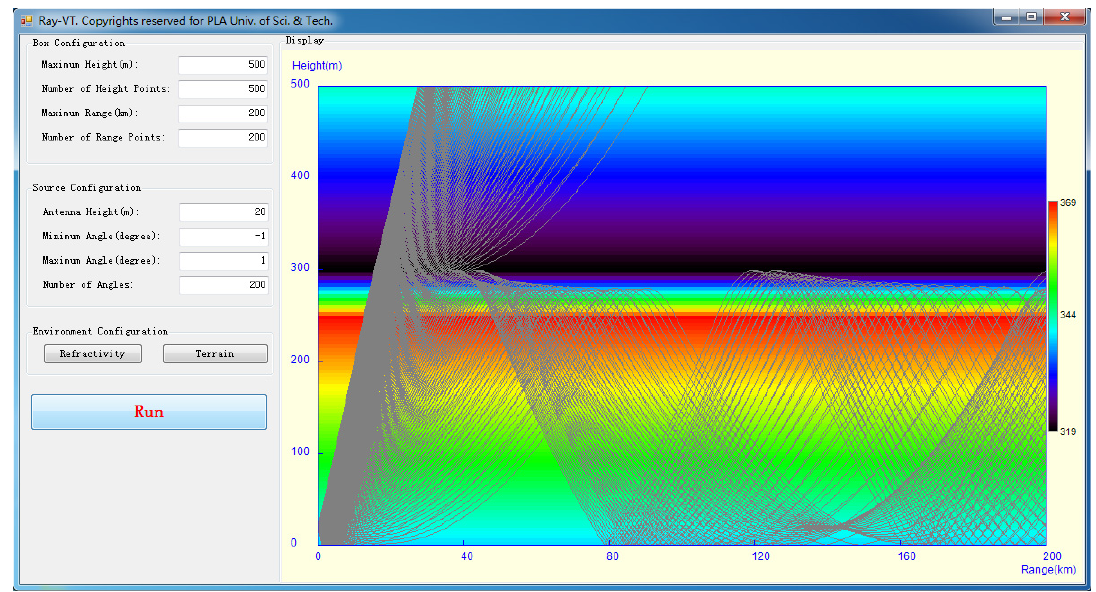
Figure 4. GUI of the Ray-VT for rays propagating through a 300 m surface-based duct on a flat terrain. Atmosphere 2017 , 8 , 35